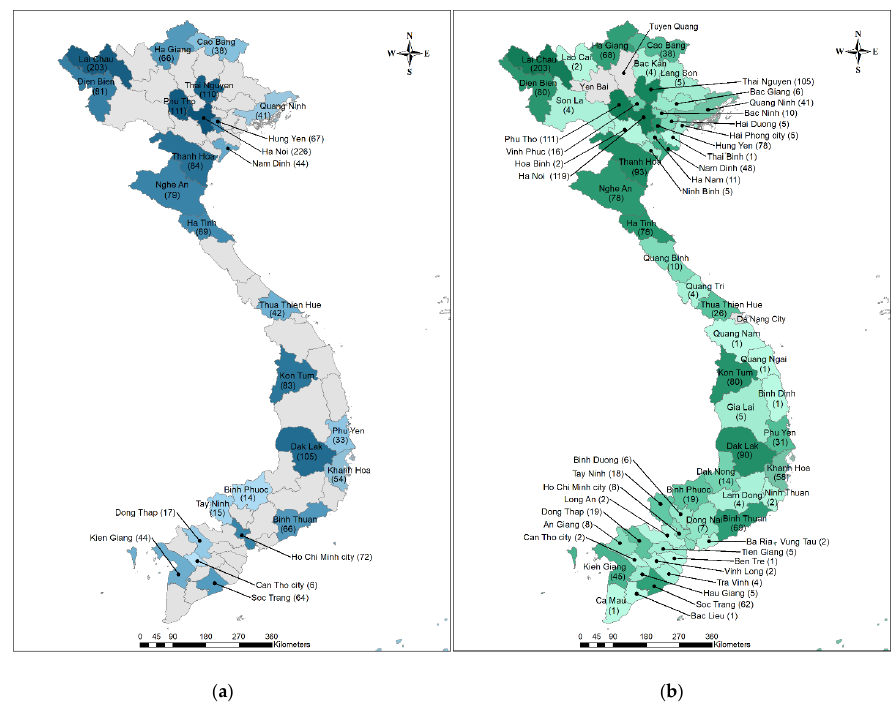
Figure 2. Frequency and Distribution of Enrolled Patients. ( a ) The number of patients that partici- pated in the study by province of hospital. ( b ) The number of patients by province of residence. The color corresponds to patient distribution with the darker the color, the higher the number of enrollees. Trop. Med. Infect. Dis. 2022 , 7 , x FOR PEER REVIEW Rickettsial DNA was detected in the PBMCs of 30.8% (564/1834) of enrolled patients. Of those, 11.9% (67) were positive by qPCR for Rickettsia typhi, and 85.8% (484) were pos- itive by qPCR for Orientia tsutsugamushi (Figure 3). No samples were positive for R. prowazekii. Ten samples were positive using the Rickettsia genus-specific assay (Rick17b), but negative by either of the R. typhi or R. prowazekii assays. These Rick17b positive sam- ples were subjected to multilocus sequence typing (MLST) targeting the conserved genes 17kDa antigen gene and gltA as well as the variable genes ompA, ompB, and sca4 to deter- mine the species of Rickettsia present in the samples. Due to low levels of the rickettsiae in the PMBCs, (Rick17b Ct values ranged from 35 to 38) amplicons were not obtained for any of the genes and the specific identify of the rickettsiae could not be determined. Given that the samples were positive for rickettsiae, but negative for any of the typhus group rickett- siae, the rickettsiae in these samples most likely belong to the spotted fever rickettsiae antigenic group. In addition, three (0.5%) patients were qPCR positive for both scrub ty- phus and rickettsiosis, with the following Otsu47 and Rick17b Ct values (34 and 36; 34 and 37; 34 and 36, respectively).